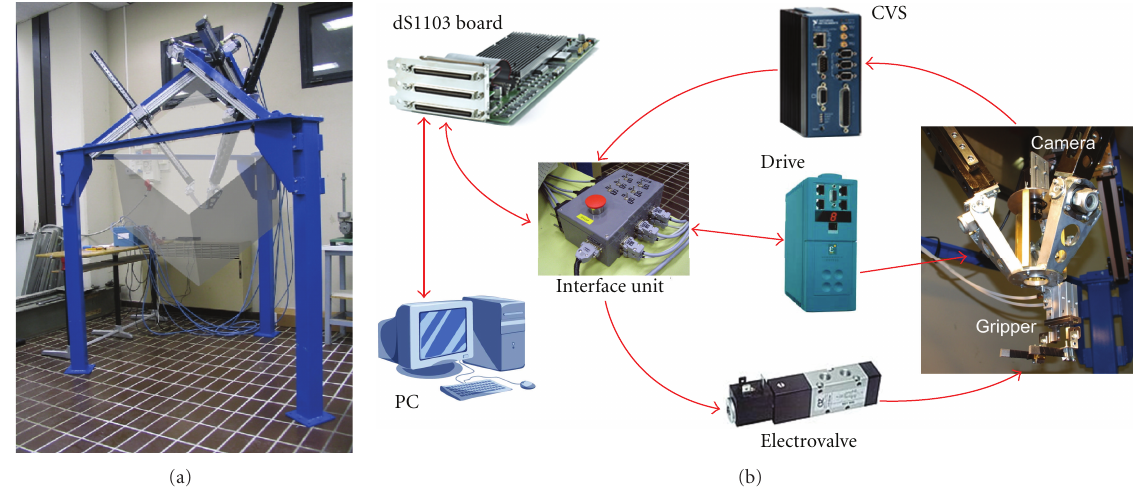
Figure 1: (a) ICaRo robot and workspace; (b) system architecture and connection